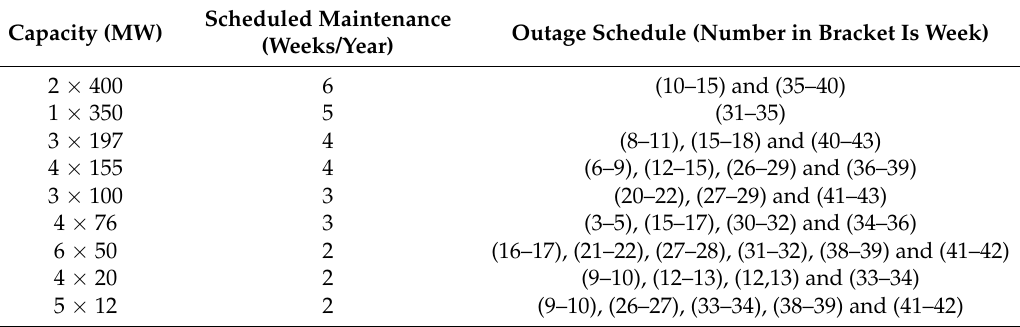
Table 1. Planned maintenance schedule for each generation unit